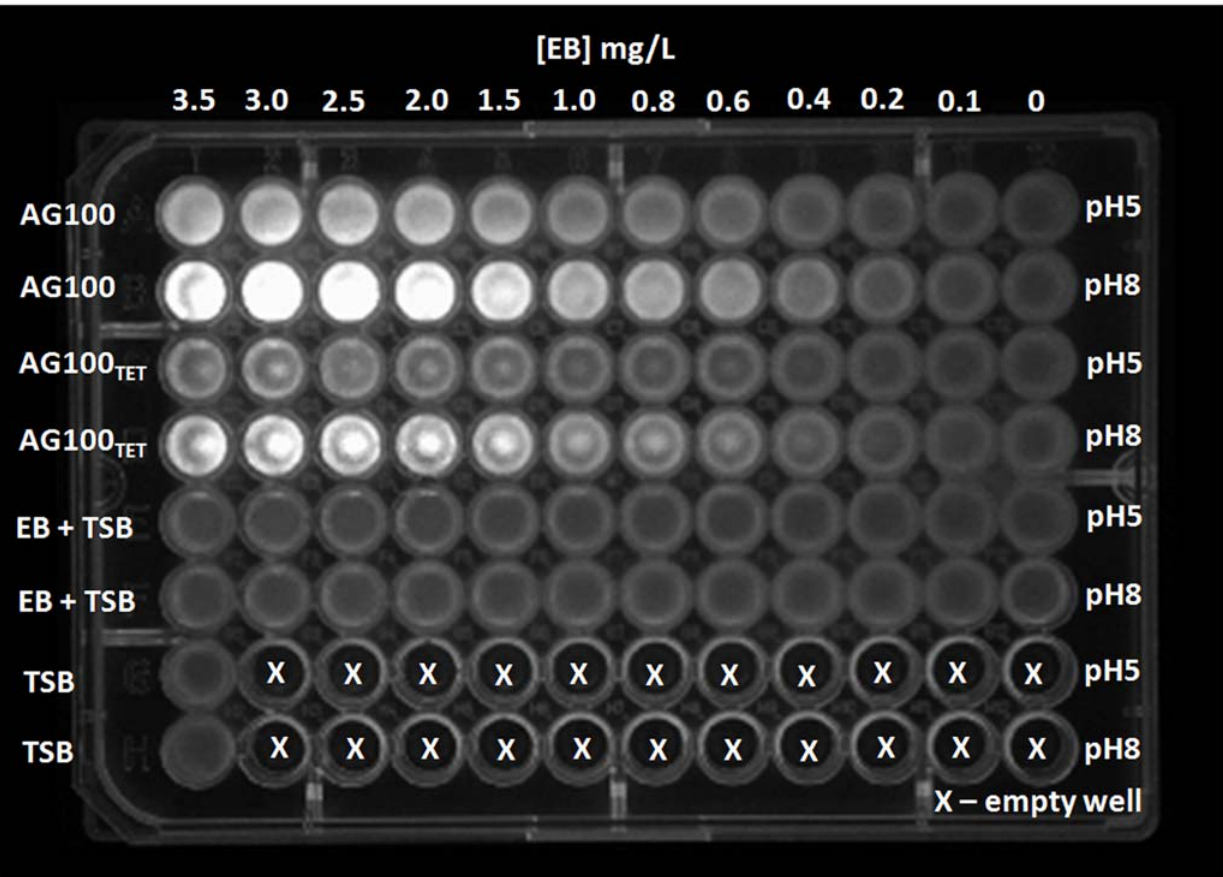
Figure 1. Fluorescence of the strains E.coli AG100 and AG100 TET in EB containing media at pH 5 and pH 8. From the left to the right, the fluorescence emitted by the bacteria grown in decreasing concentrations of EB during 16 hours. The controls of the media (TSB with or without EB) at pH 5 and pH 8 are presented in the last four rows of the plate.